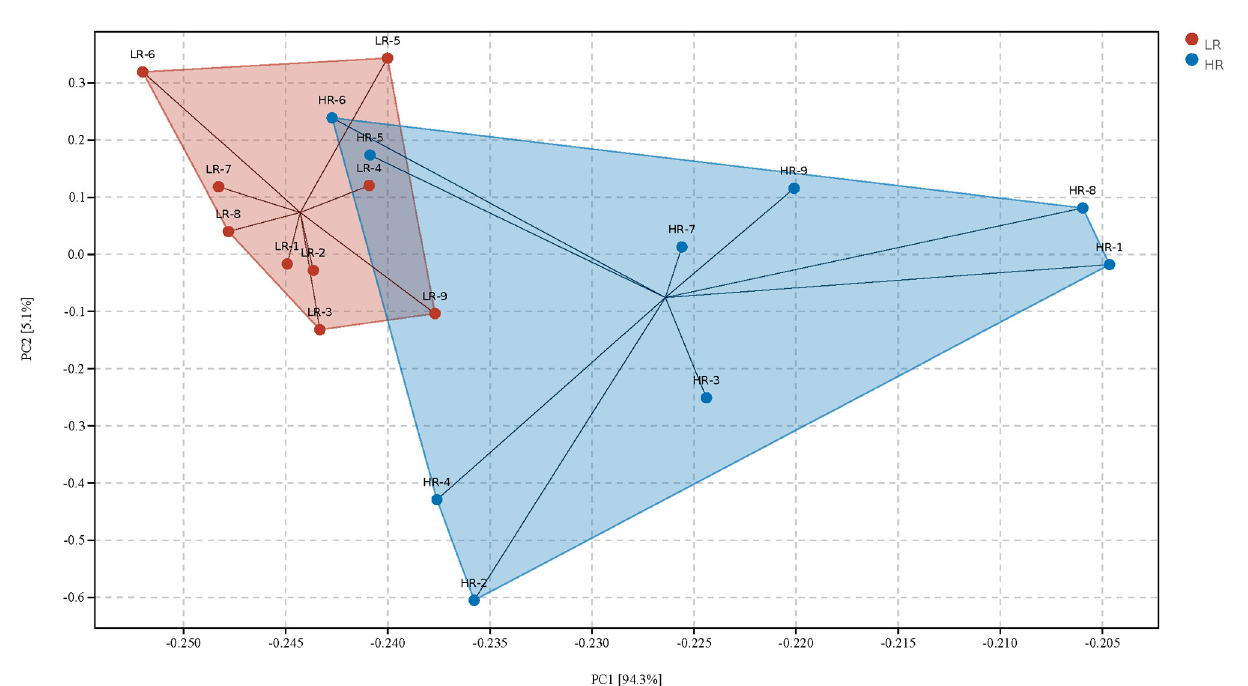
FIGURE2 Principal component analysis of the gut microbiota community structures between high- and the low-residue feed intake ducks. LR, low residual feed intake; HR, high residual feed